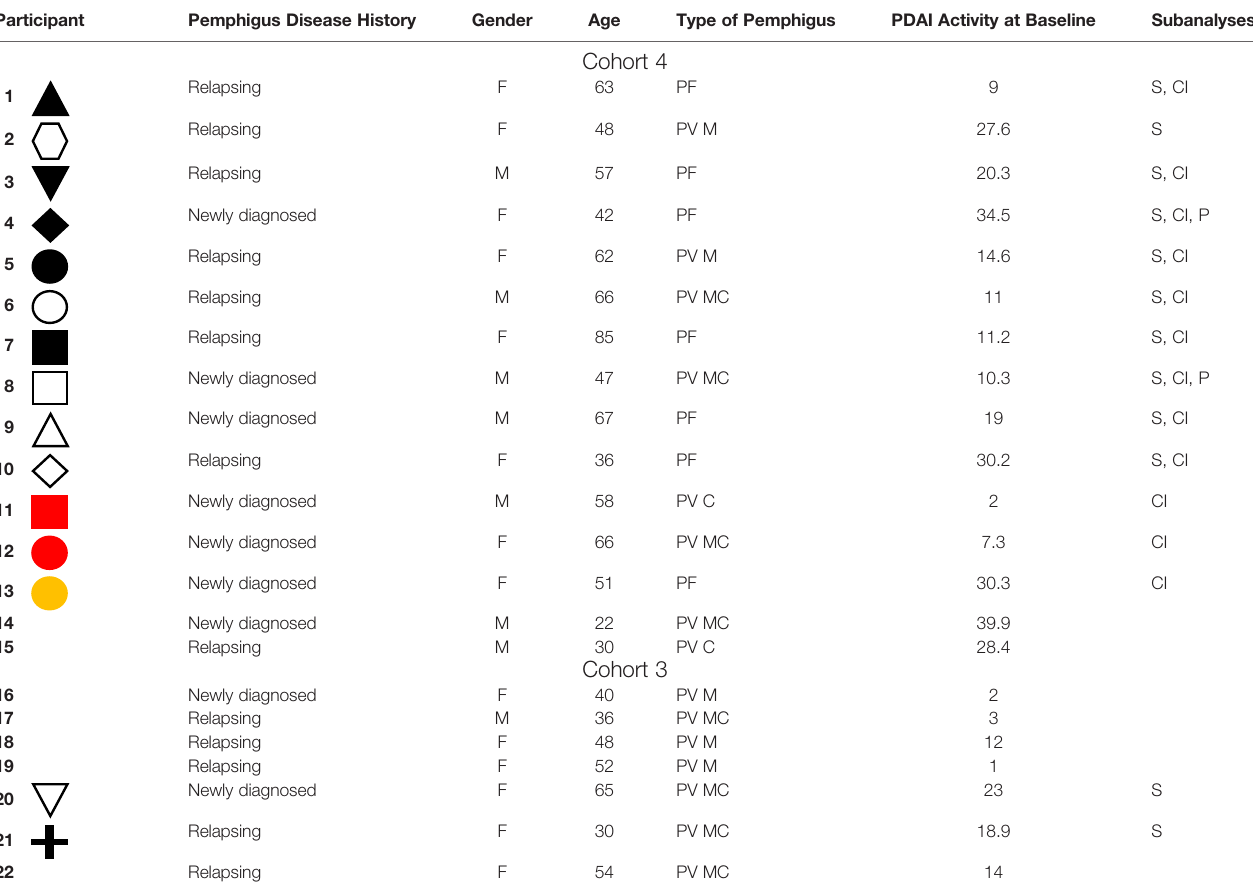
TABLE 1 | Baseline characteristics of participants receiving extended efgartigimod treatment in cohorts 3 and 4.